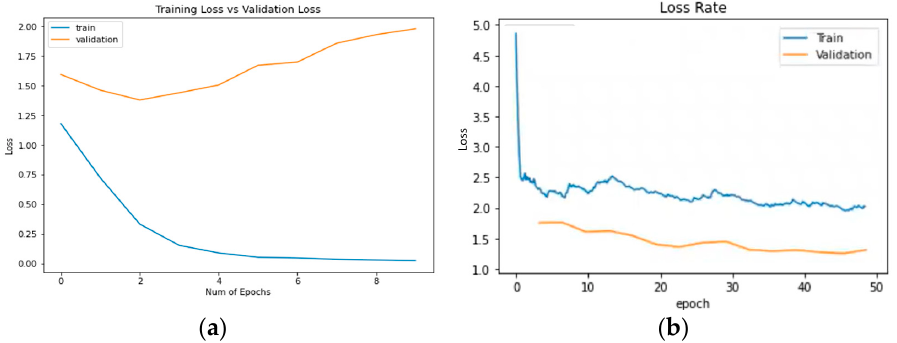
Figure 8. Plots of training and validation accuracy of the networks: ( a ) LSTM NN and ( b ) ResNet34.